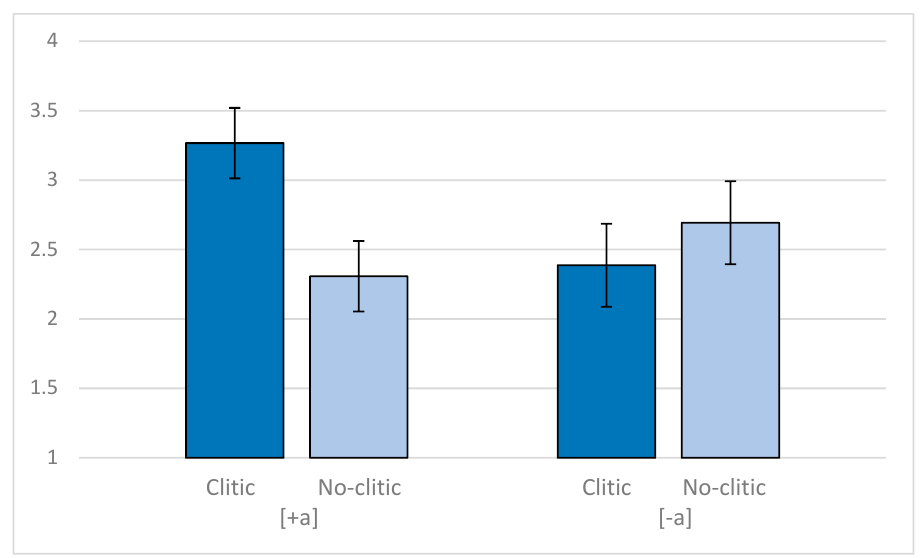
Figure 2. Heritage group ratings on the AJT by discourse context and clitic presence. Error bars represent 95% confidence intervals.